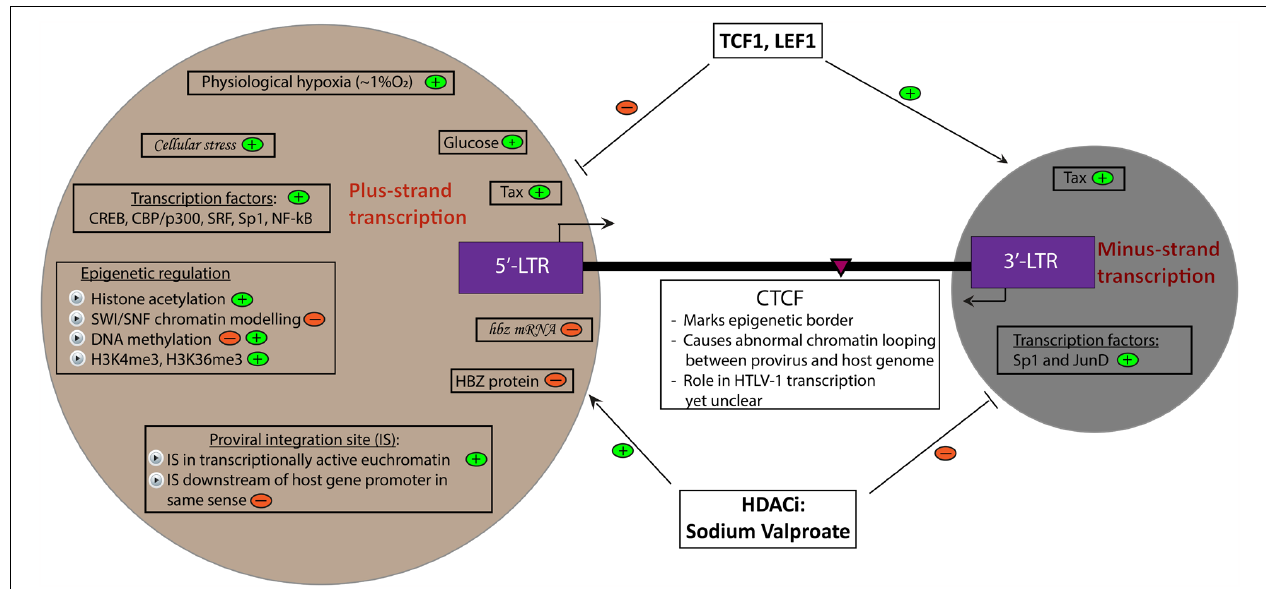
FIGURE 1 | Determinants of HTLV-1 plus- and minus-strand transcription. A summary of currently known factors that induce (depicted by ) and inhibit (depicted by ) plus- and minus-strand transcription of the HTLV-1 provirus. Italicized words denote hypothetical factors. The pink arrowhead marks the position of the CTCF binding site in the